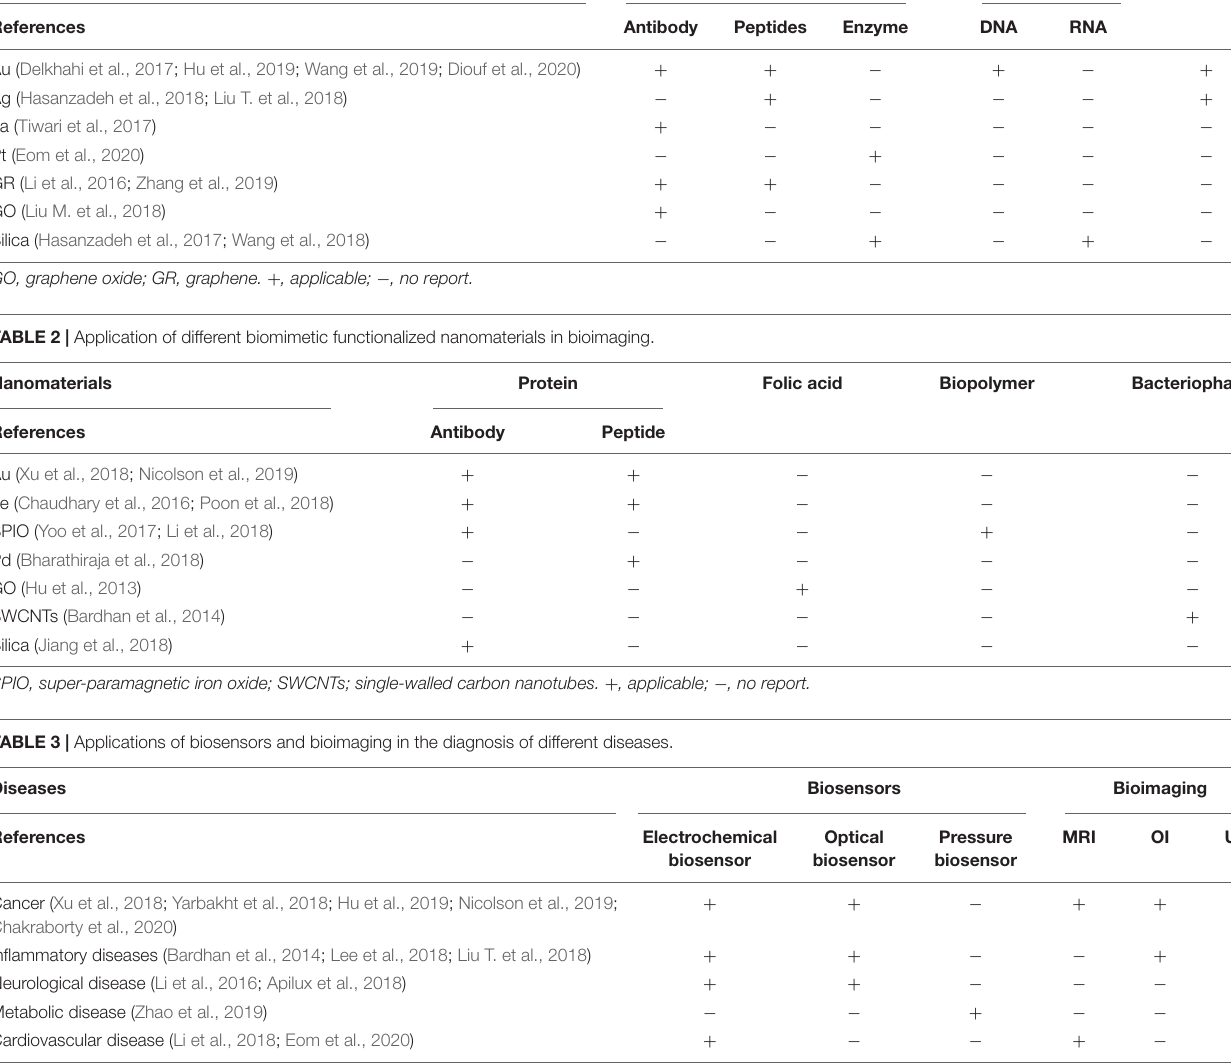
TABLE 1 | Application of different biomimetic functionalized nanomaterials in biosensors. Nanomaterials